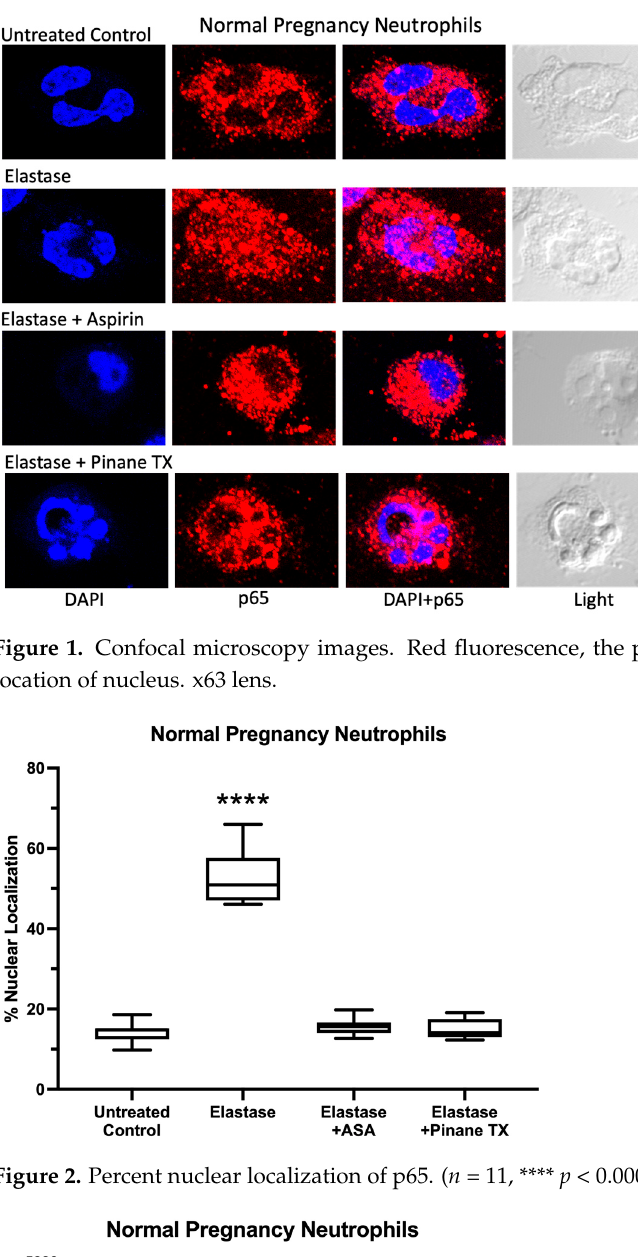
Figure 2. Percent nuclear localization of p65. ( n = 11, **** p < 0.0001; ASA, aspirin).